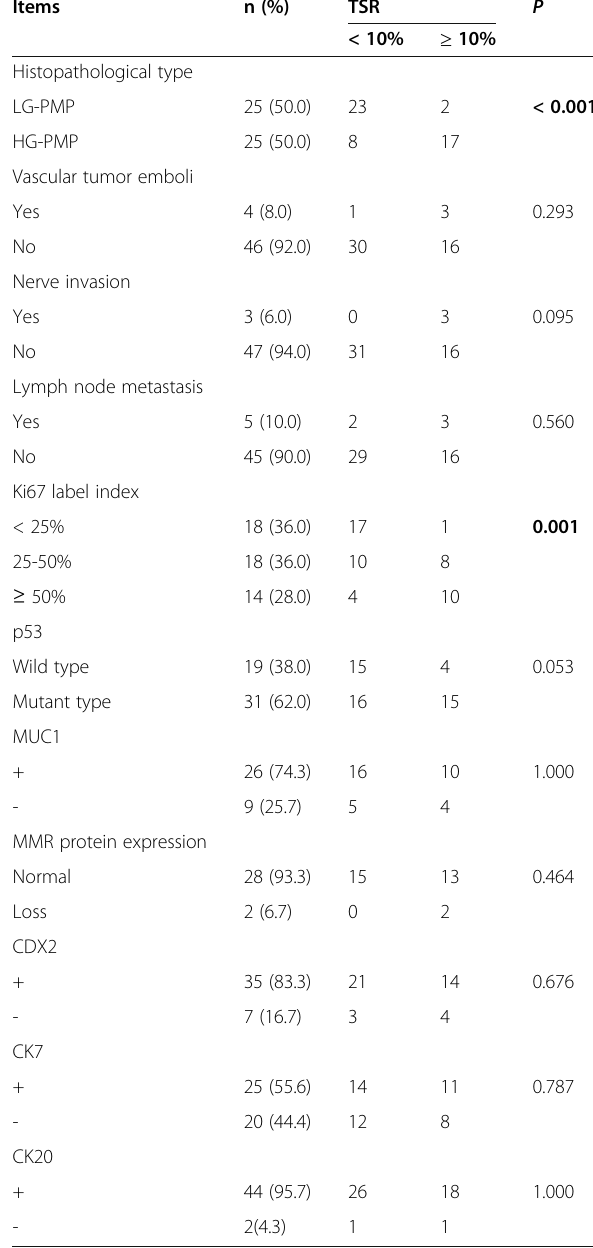
Table 2 The relationship between TSR and pathological characteristics of